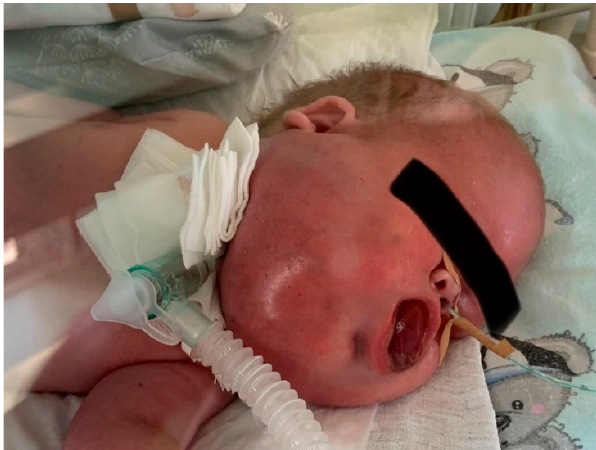
Figure 5. The infant with tracheostomy and lymphatic edema.